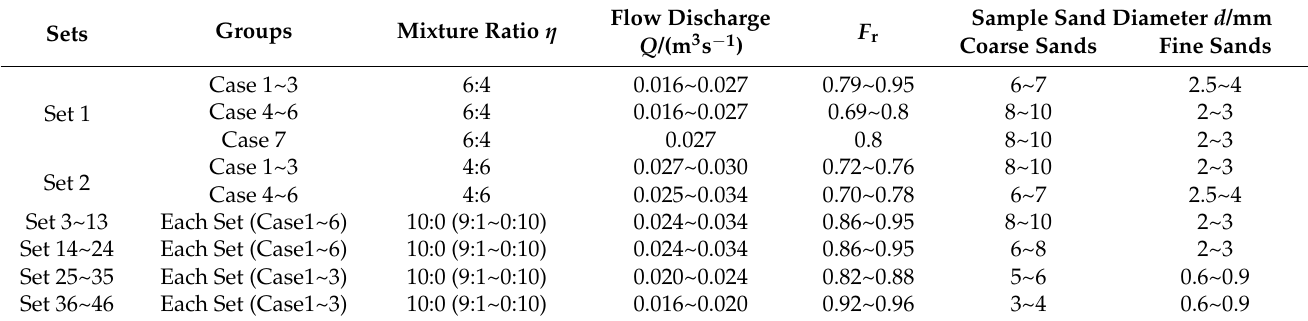
Table 2. The hydraulic and sediment parameters of